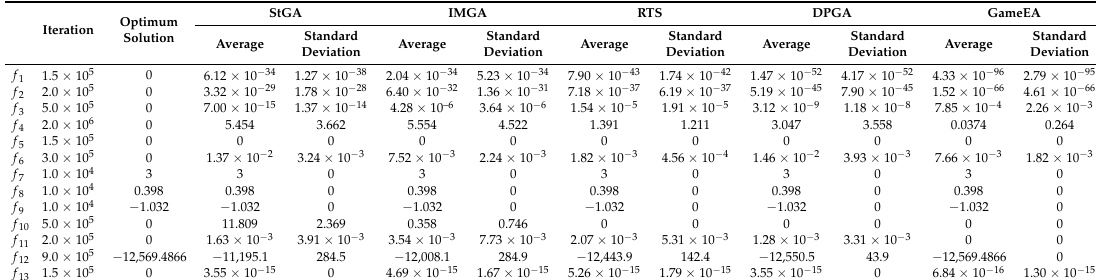
Table 3. Fifty independent experimental statistics results based on StGA, IMGA, RTS, DPGA, and GameEA using real-valued representations of functions f 1 − f 13